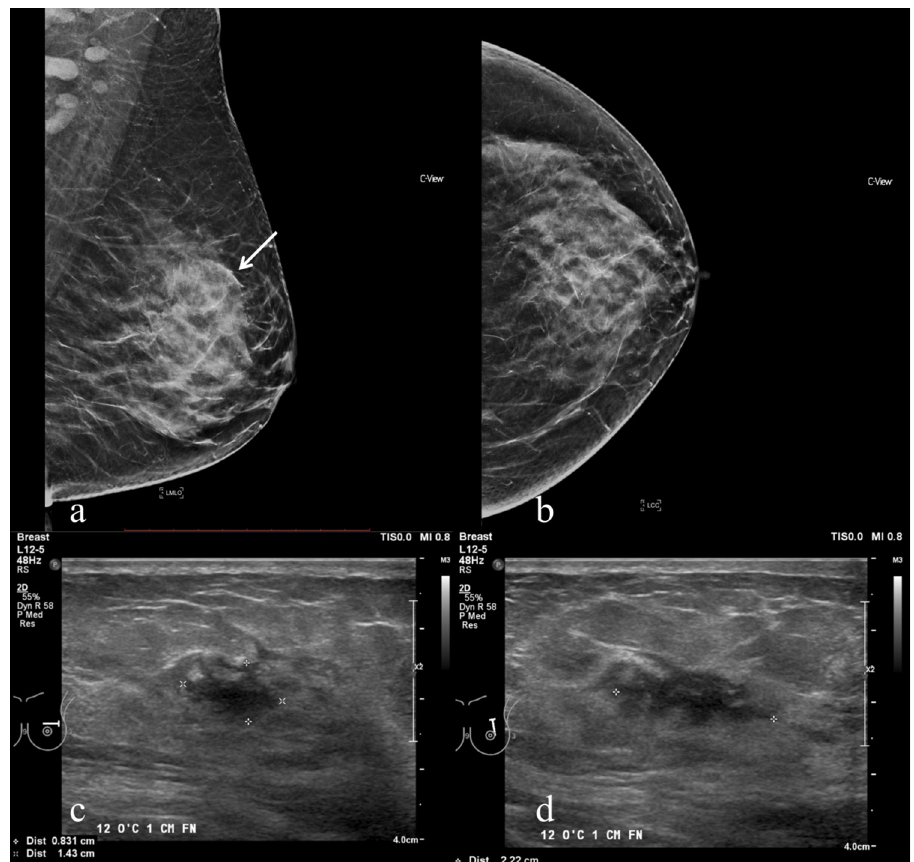
Fig 6. 49-year-old woman with left breast invasive carcinoma who was deemed eligible for IORT based on conventional imaging but the tumour was larger than 30mm on MRI (done 4 days apart). Left MMG in (A) MLO and (B) CC view showing an indistinct high-density mass (thin arrow) in the left upper central region in a background of dense breast parenchyma BIRADS. (C) Corresponding ultrasound of the left breast in (C) transverse and (D) longitudinal views show irregular hypoechoic lesion with angular margins. The largest dimension on conventional imaging was 22mm.